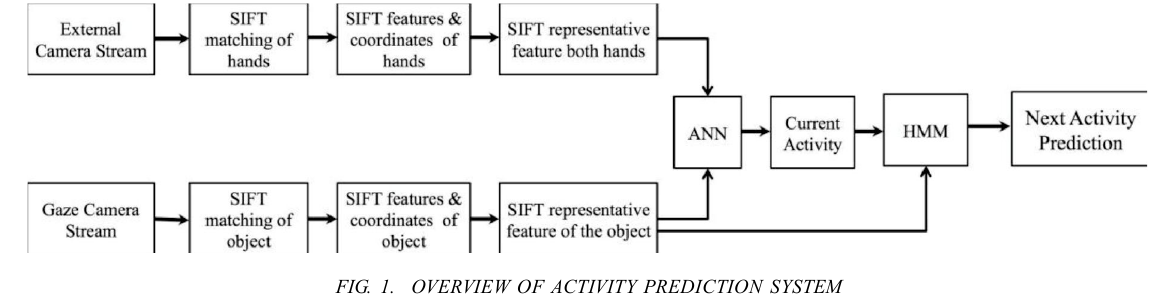
FIG. 1. OVERVIEW OF ACTIVITY PREDICTION